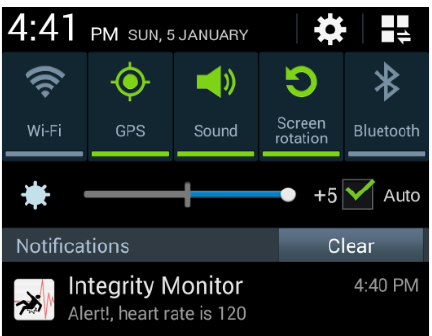
Figure 12. Push notification generated for the heart rate